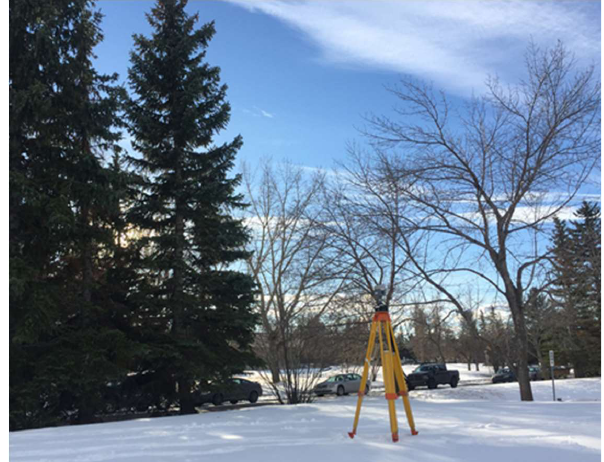
Figure 3. Observation environment of dataset no. 2 near trees.